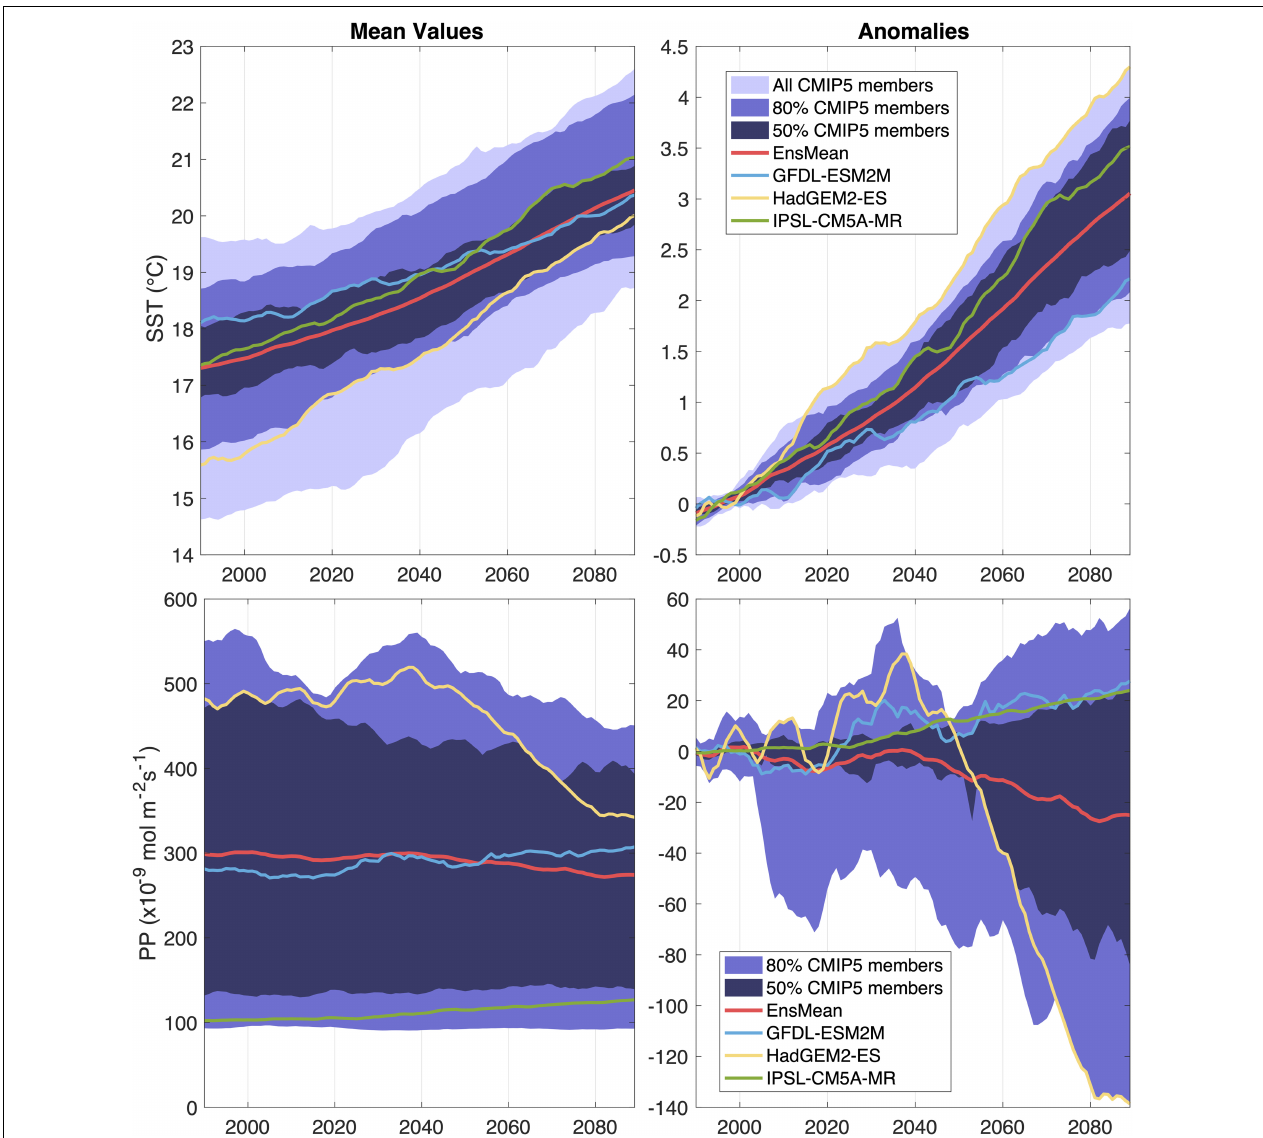
FIGURE 1 | Time series of yearly averages of the California Current sea surface temperature (SST, first row) and primary production (PP, second row) for the 1976–2099 period, averaged over the California Current Large Marine Ecosystem. The simulations are forced using historical emissions (1976 to 2005) and the RCP8.5 scenario for future projection (2006 to 2099). Left panels show the mean values and right panels show the anomalies relative to the 1976–2005 climatology. A 20-year running mean is applied. The figure is adapted from the NOAA climate website